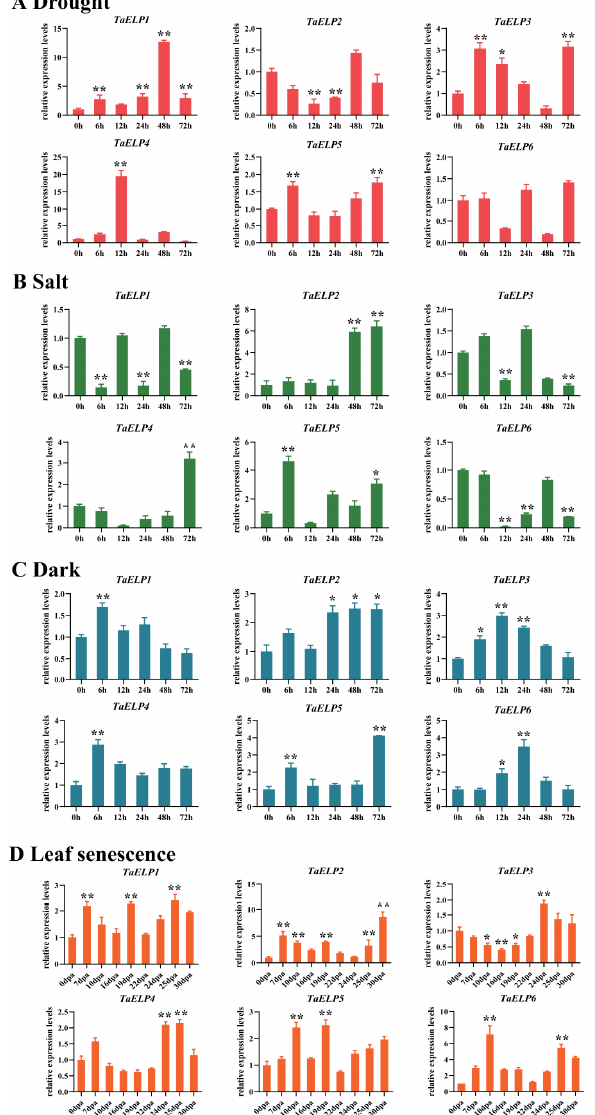
Figure 7. Relative expression profiles of TaELPs in response to ( A ) drought stress, ( B ) salt stress, ( C ) dark stress, and ( D ) leaf senescence. The 0 h post-treatment for A, B, and C or 0 days after anthesis for D were used as a control. The relative transcripts of all genes were analyzed using qRT-PCR. The relative transcript levels of TaELPs were measured using the comparative threshold (2 −ΔΔCT ) method. Data normalized with the transcripts of wheat elongation factor TaEF-1α . The 0 h post-treatment and 0 days after anthesis was used as a control and standardized with 1. Values represent the mean ± SE from three independent biological samples. Asterisks ( p < 0.05) or double asterisks ( p < 0.01) designate significant differences from 0 hpt or 0 days after anthesis by the Student’s t